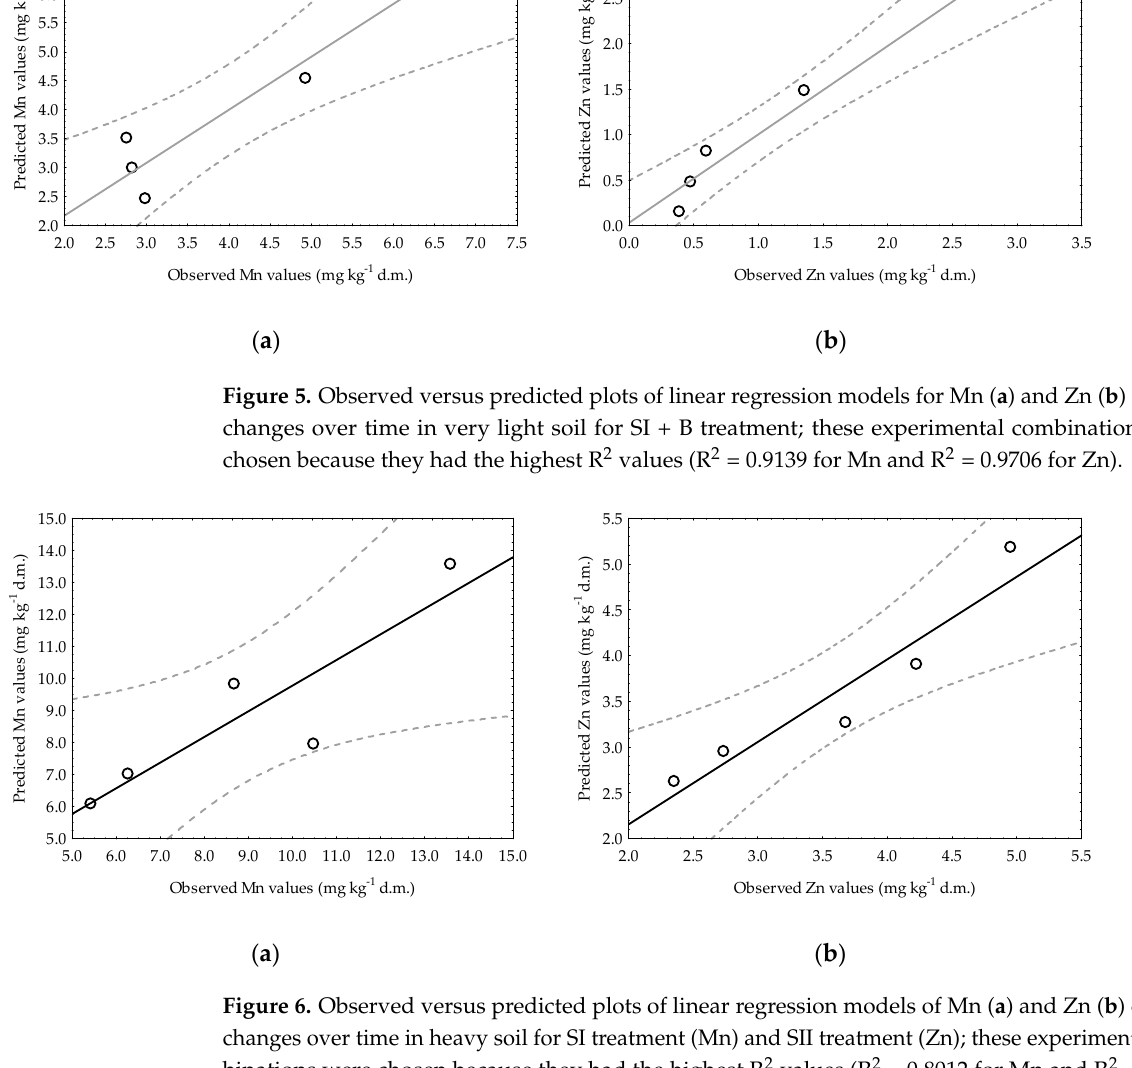
Figure 5. Observed versus predicted plots of linear regression models for Mn ( a ) and Zn ( b ) content changes over time in very light soil for SI + B treatment; these experimental combinations were cho- sen because they had the highest R 2 values (R 2 = 0.9139 for Mn and R 2 = 0.9706 for Zn).